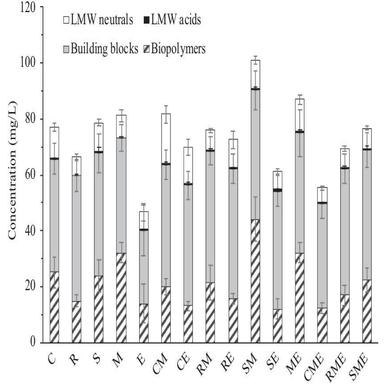
Average concentrations of organic fractions in different cultures after Day 20 (n = 5), with error bars displaying the corresponding standard deviation.